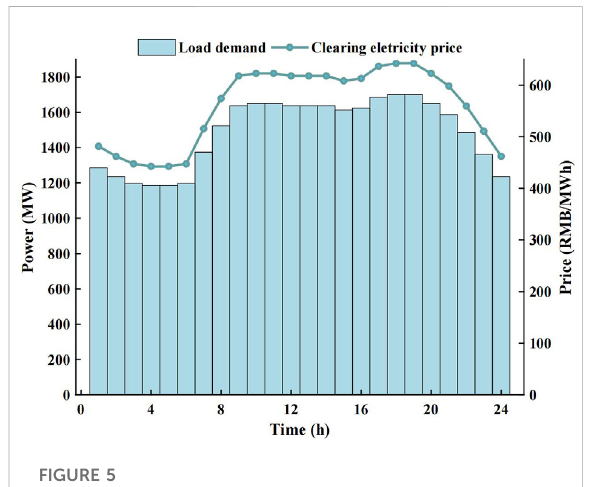
FIGURE 7 Carbon emission of